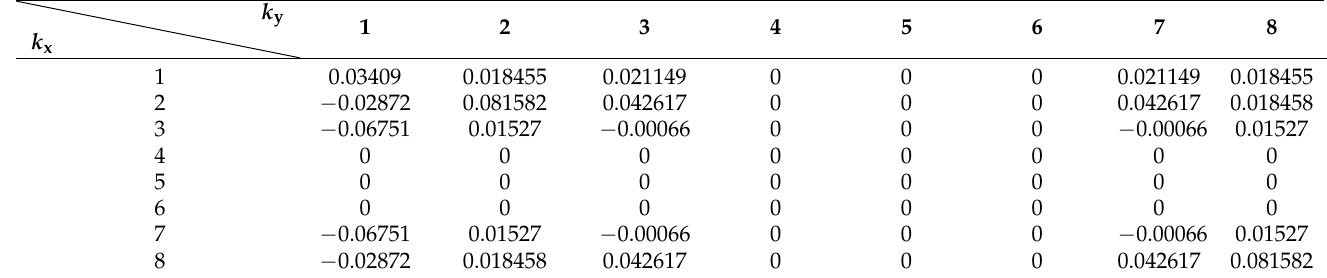
Table 4. Regenerated angular spectrum value after